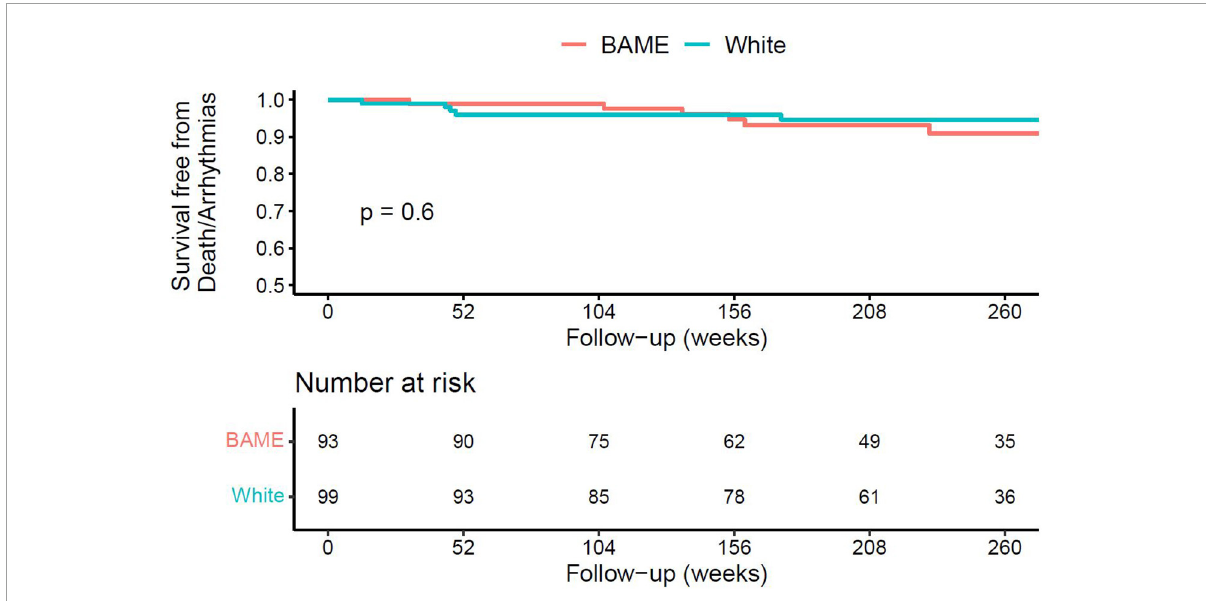
FIGURE3 Kaplan–Meier curve for all-cause mortality, resuscitated cardiac arrest, and appropriate implantable cardioverter defibrillator (ICD) therapy following hospital discharge in patients with AM, according to sex.